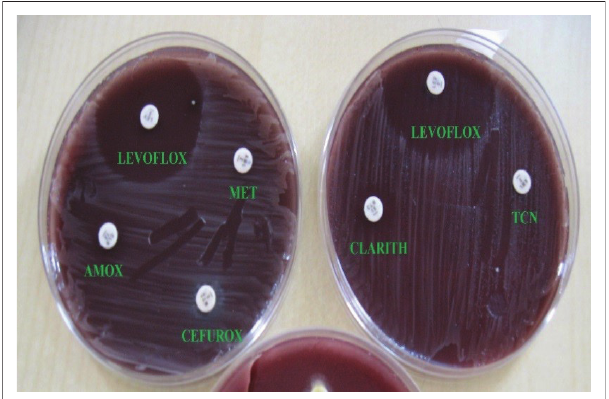
FIGURE 4: Positive Helicobacter pylori faecal antigen test (presence of horizontal line on C